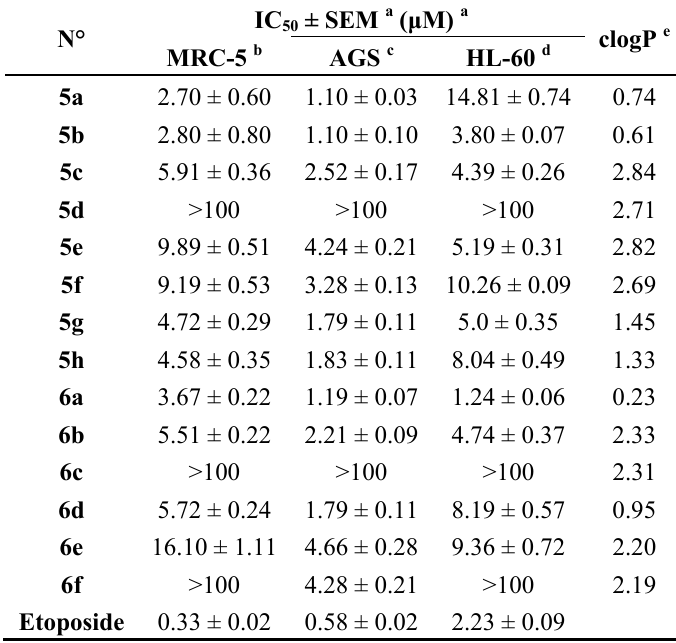
Table 4. Antiproliferative activity of 7-aminophenyl-1-arylisoquinolinequinones 5 and 6